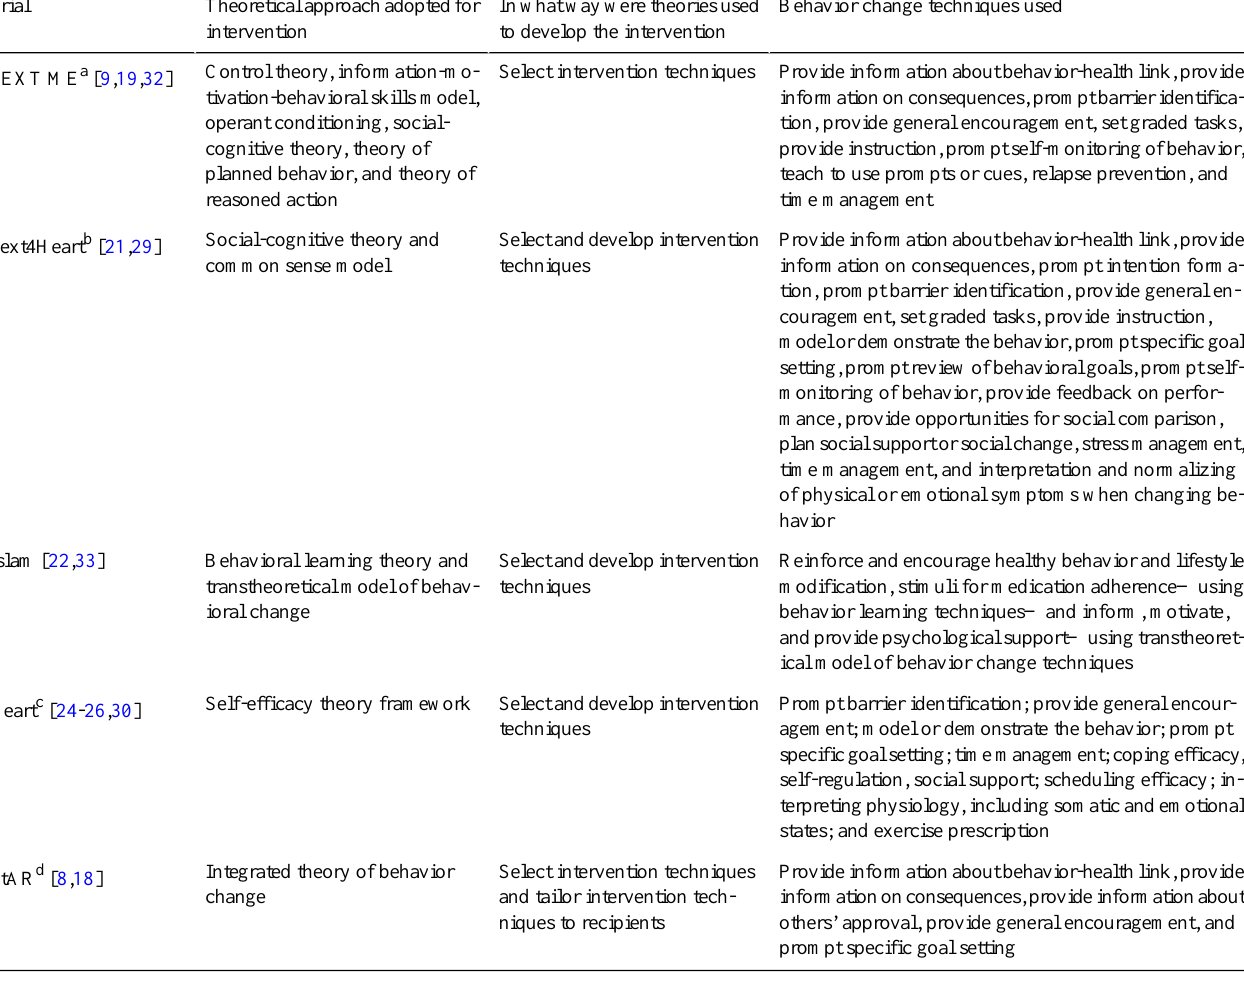
Table 2. Intervention design: use of theory and behavior change techniques. Behavior change techniques usedIn what way were theories used interventionTheoretical approach adopted for interventionTrial to develop the Provide information about behavior-health link, provide information on consequences, prompt barrier identifica- tion, provide general encouragement, set graded tasks, provide instruction, prompt self-monitoring of